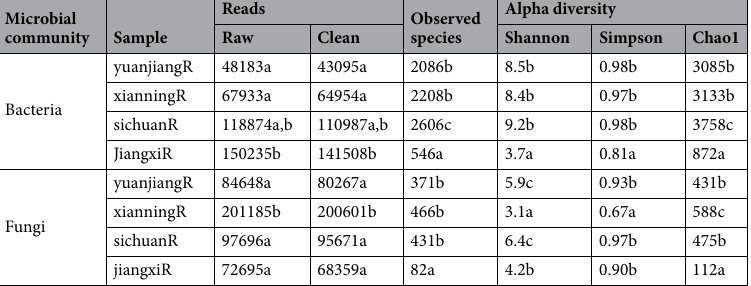
Microbial community Sample